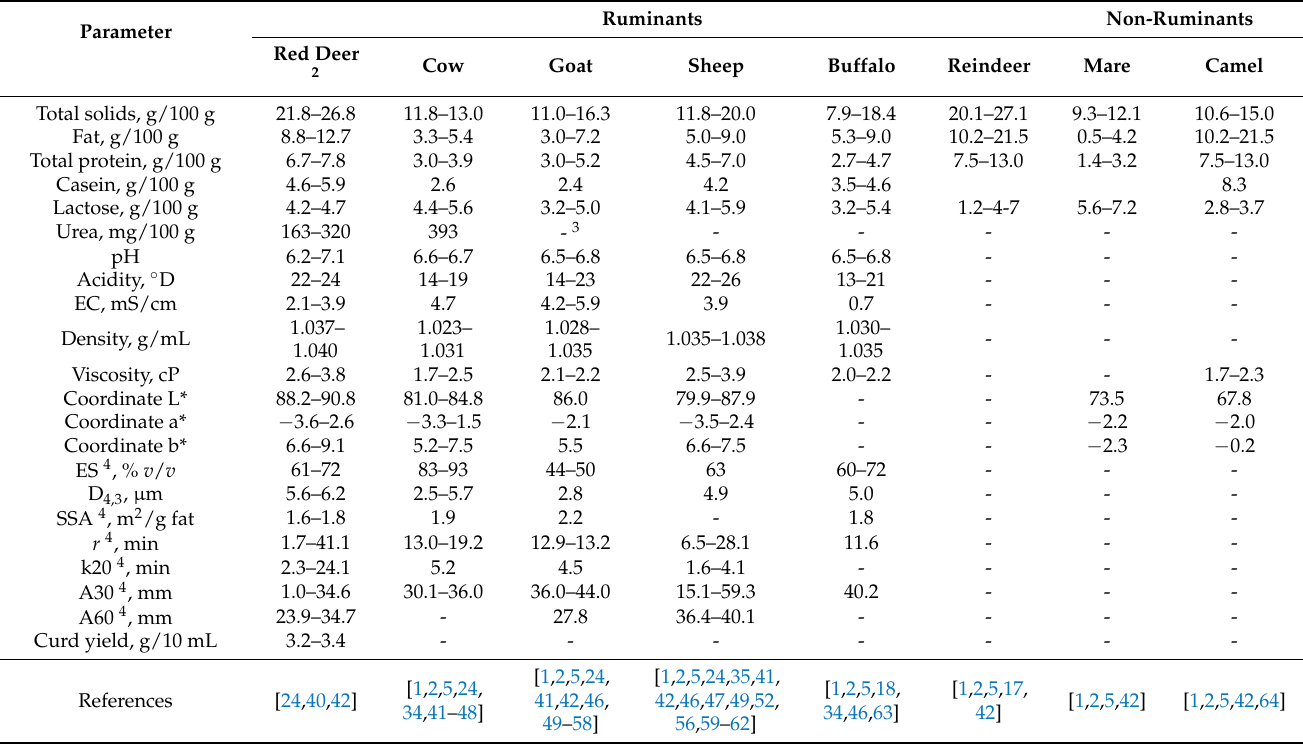
Table 2. Comparison of physicochemical and technological characteristics between different ruminant and non-ruminant species 1